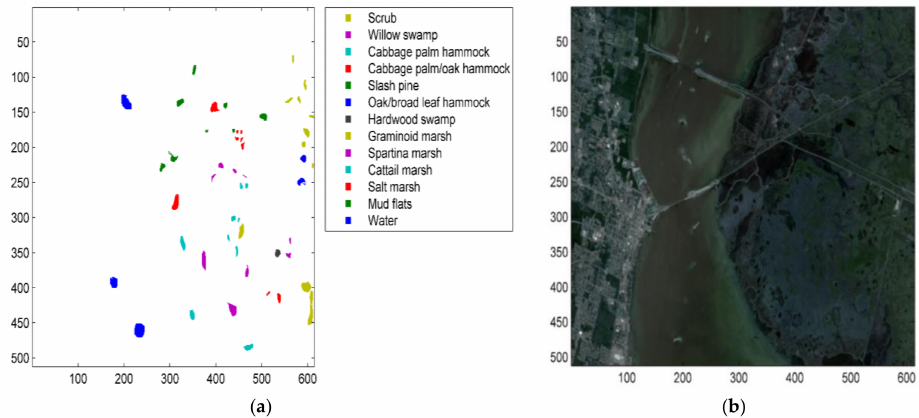
Figure 6. ( a ) Ground reference map of Kennedy Space Center dataset. ( b ) False color composition of Kennedy Space Center dataset.